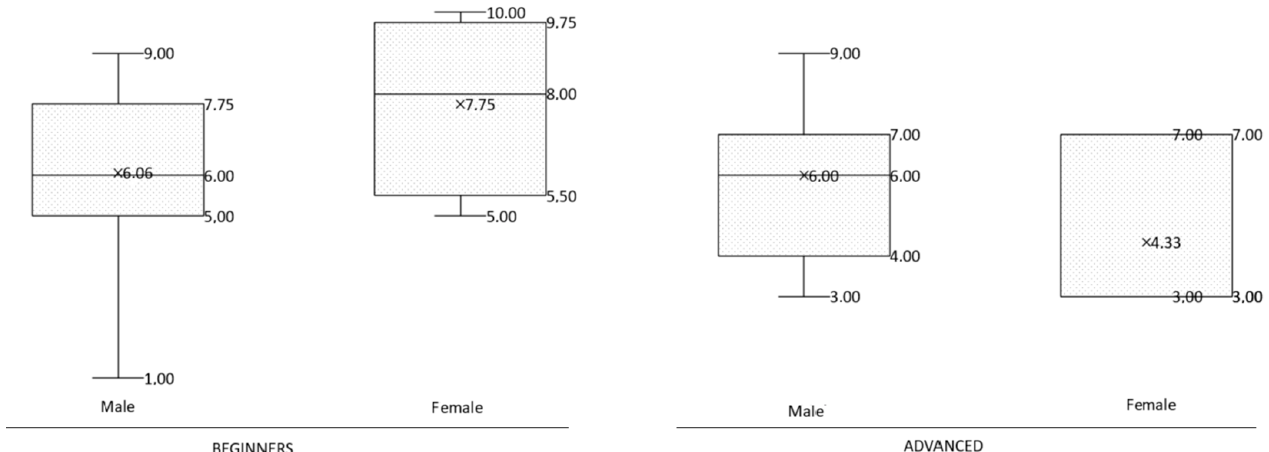
Figure 6. Average of the results of beginners and advanced groups.